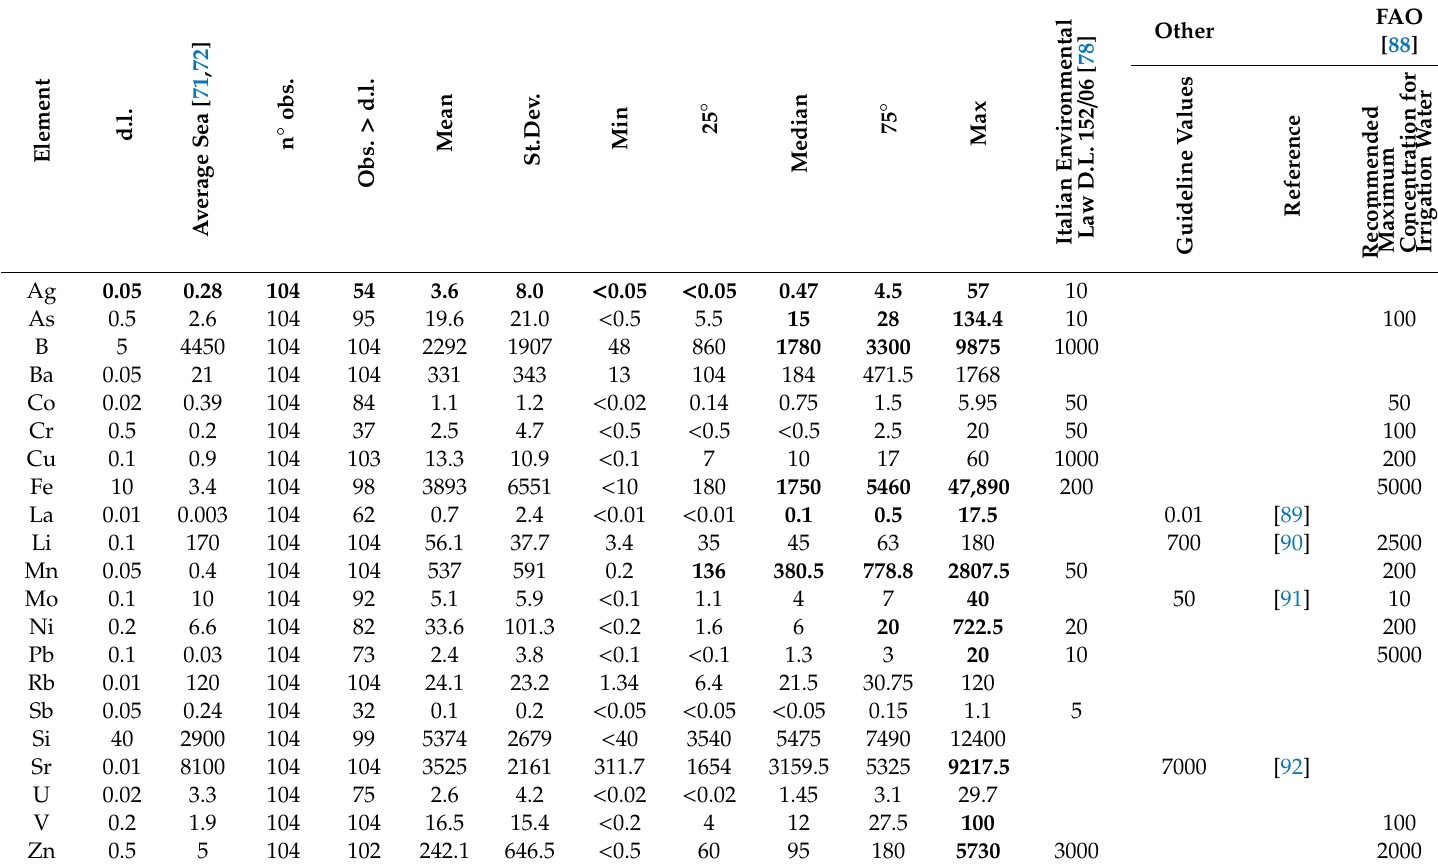
Table 1. Statistic of TEs concentrations of all water samples. Also listed are also the normative limits based on Italian Environmental Legislation 152 / 06 [73] and recommended concentration for irrigation by FAO [87]. Concentrations are in µ g / L; “d.l.” stands for detection limits. Bold concentration values indicate samples which exceed the most restrictive